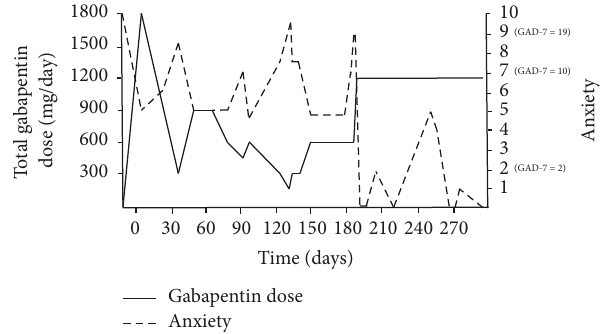
Figure 1: Relationship between gabapentin dose and anxiety . Anxiety was assessed on a 0–10 scale; GAD-7 scores are added where available. Day 0 is the day of discharge from the last hospitalization. Gabapentinisexpressedintotaldailydoses.Measurementswerenot continuous, but for clarity lines connect the values obtained during in-office follow-up appointments or telephone conversations (a total of 27 measurements in 294